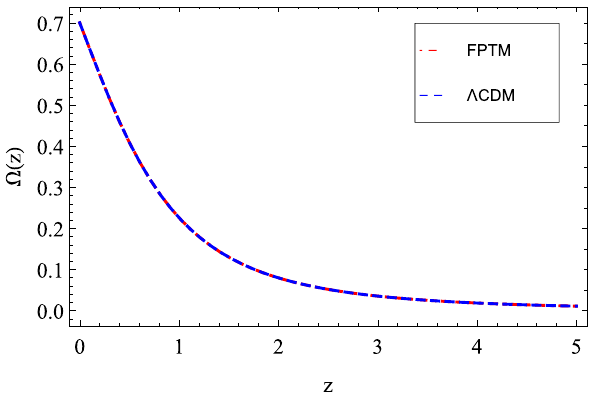
Fig. 10 The variation of energy density parameter Ω( z ) versus z for the Λ CDM and FPTM models